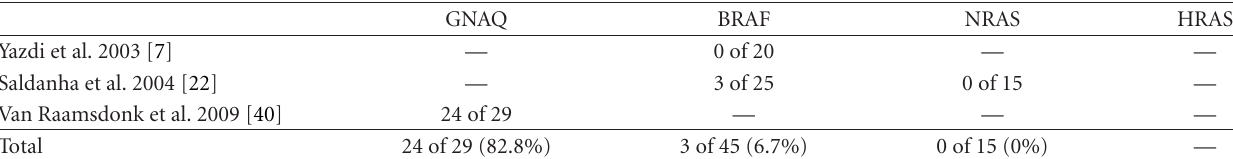
Table 4: Blue nevi.